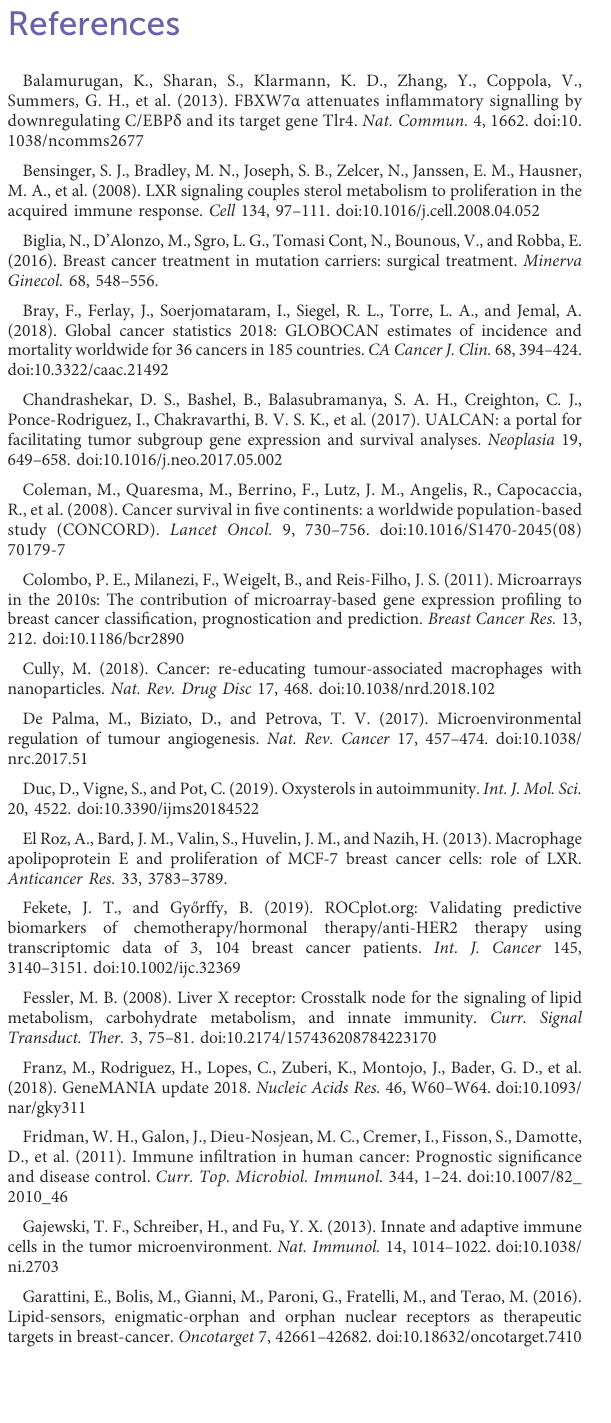
pathological response for Anthracycline treatment. RFS, relapse-free survival. SUPPLEMENTARY FIGURE S15 Association between NR1H3 and pathological response for Taxane (A), FAC (B), FEC (C) and Ixabepilone (D) treatment in breast cancer patients. FAC, Fluorouracil, Adriamycin, Cytoxan; FEC, Fluorouracil, Epirubicin,